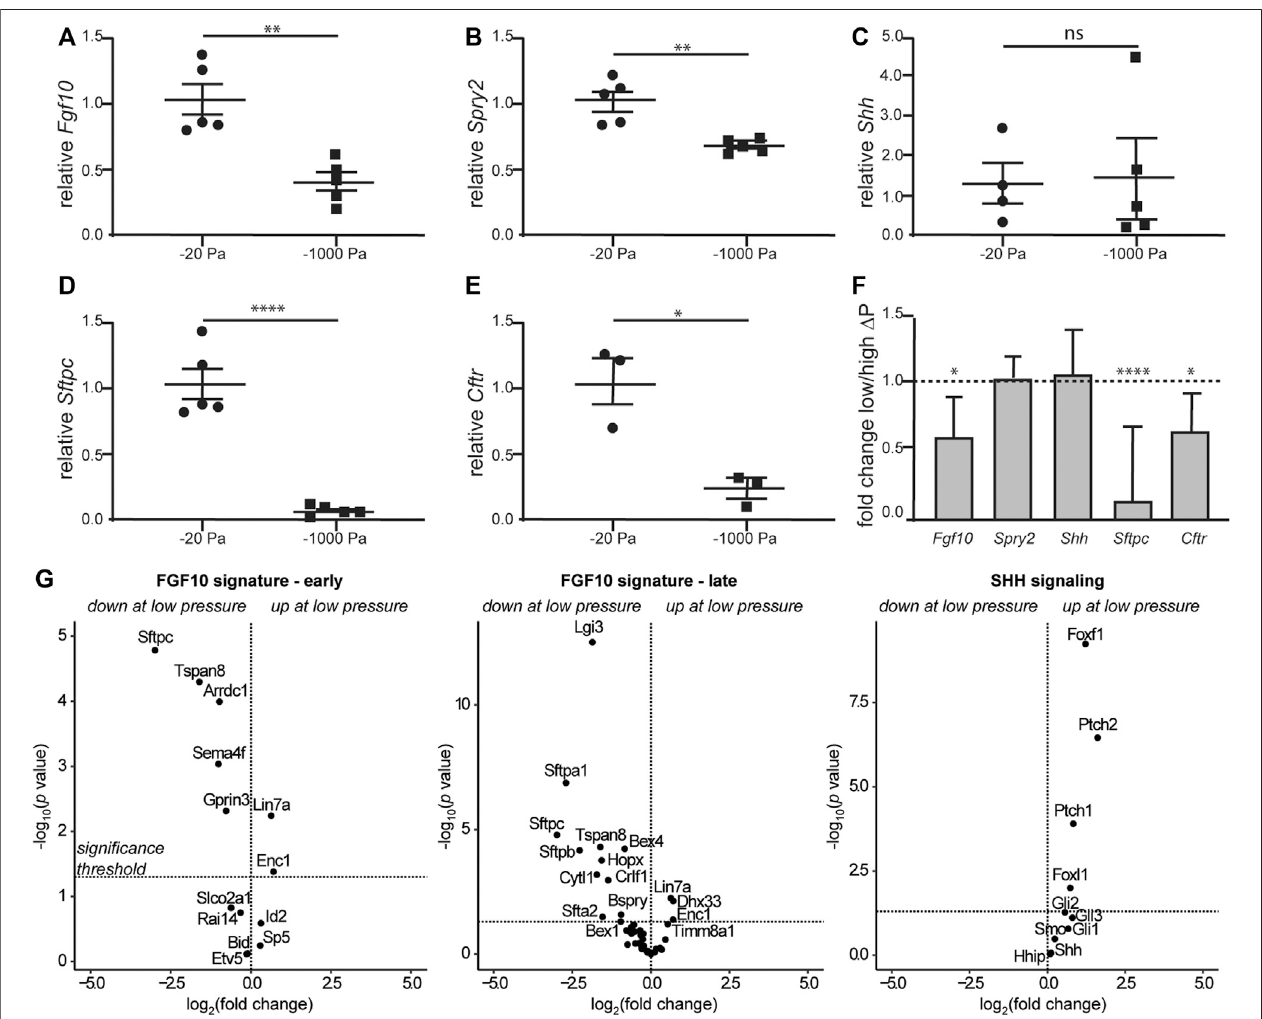
FIGURE 6 | Negative transpulmonary pressure results in reduced expression of branching regulators and markers of lung maturation. (A – E) Quantitative RT-PCR analysis for the transcript levels of (A) Fgf10 , (B) Spry2 , (C) Shh , (D) Sftpc , and (E) Cftr after 48 h of culture. Transcript levels were normalized to those of 18S for each sample. (F) Relativeexpressionofgenesinlungsheldunderlowvs.hightranspulmonarypressureasassessedbybulkRNA-seqanalysis;datafrom(Nelsonetal.,2017). N (cid:1) 3 experimental replicates; 5 data points/group for qRT-PCR experiments; 3 data points/group for qRT-PCR for Cftr . (G) Volcano plots for genes associated with early and late FGF10 or SHH